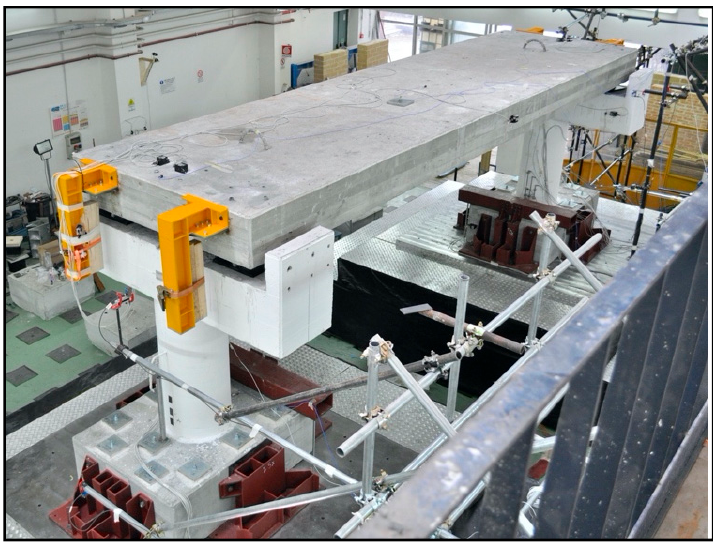
Figure 9. The scaled bridge specimen installed on the shaking table system.